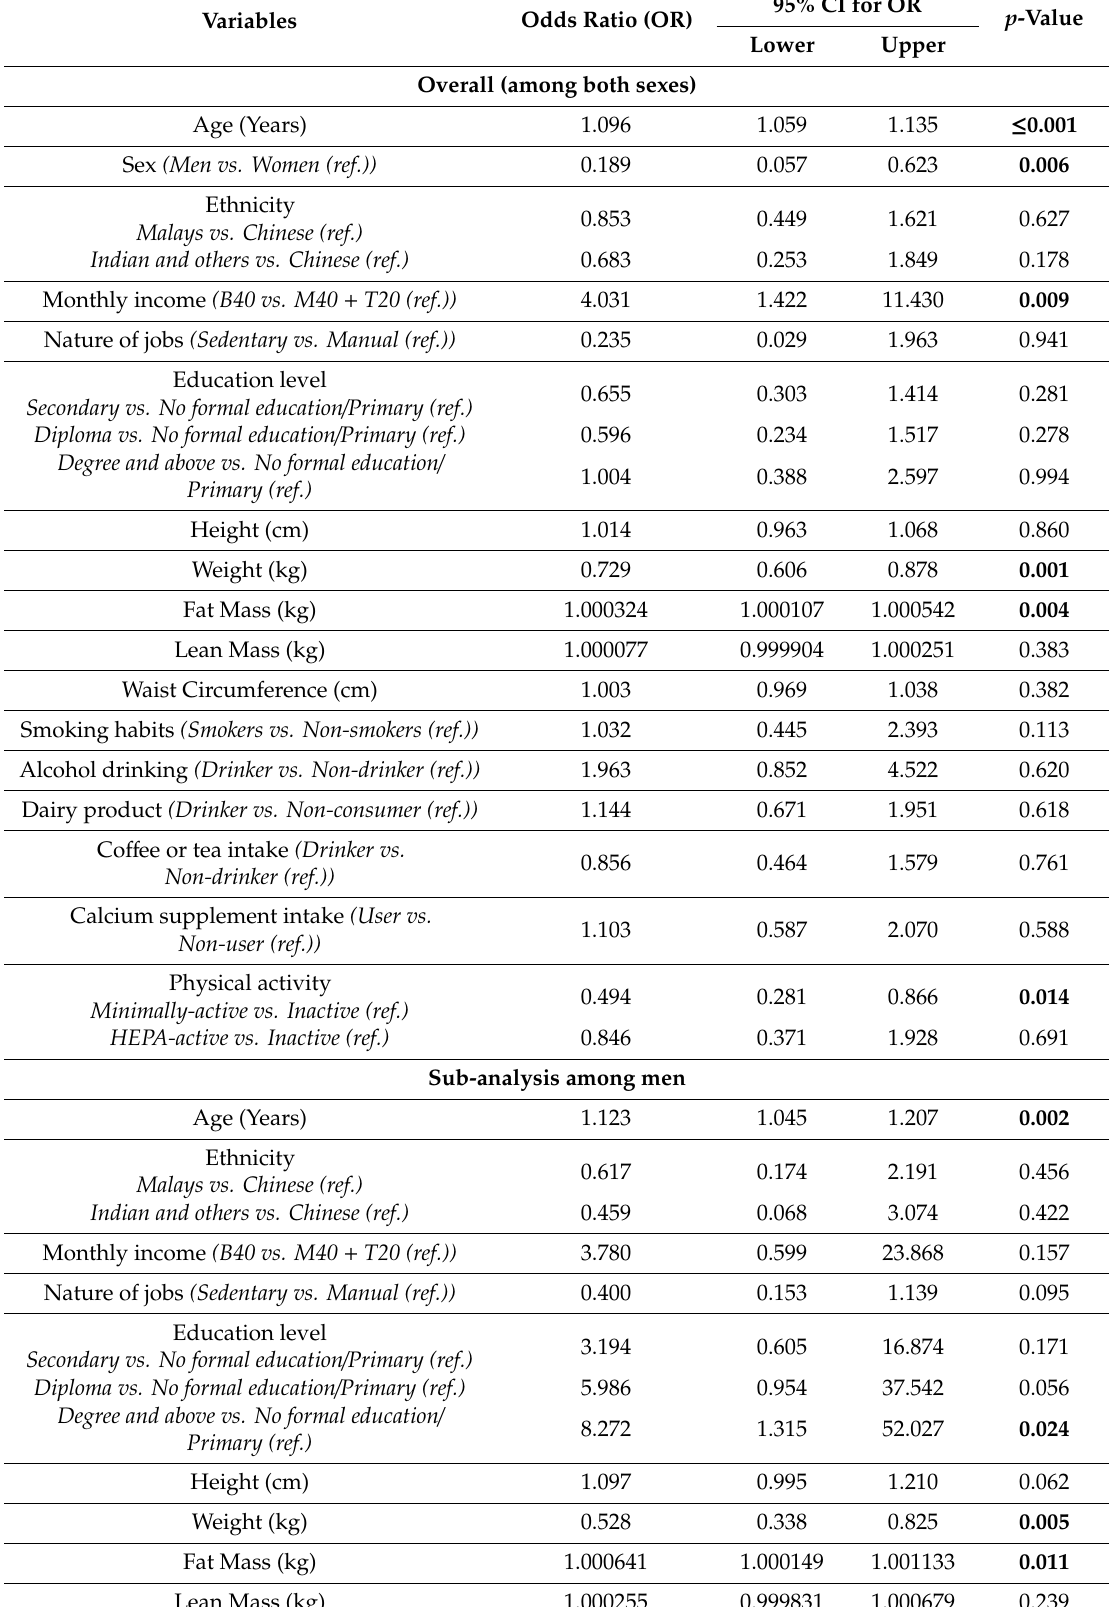
Table 2. Predictors of osteoporosis of the study